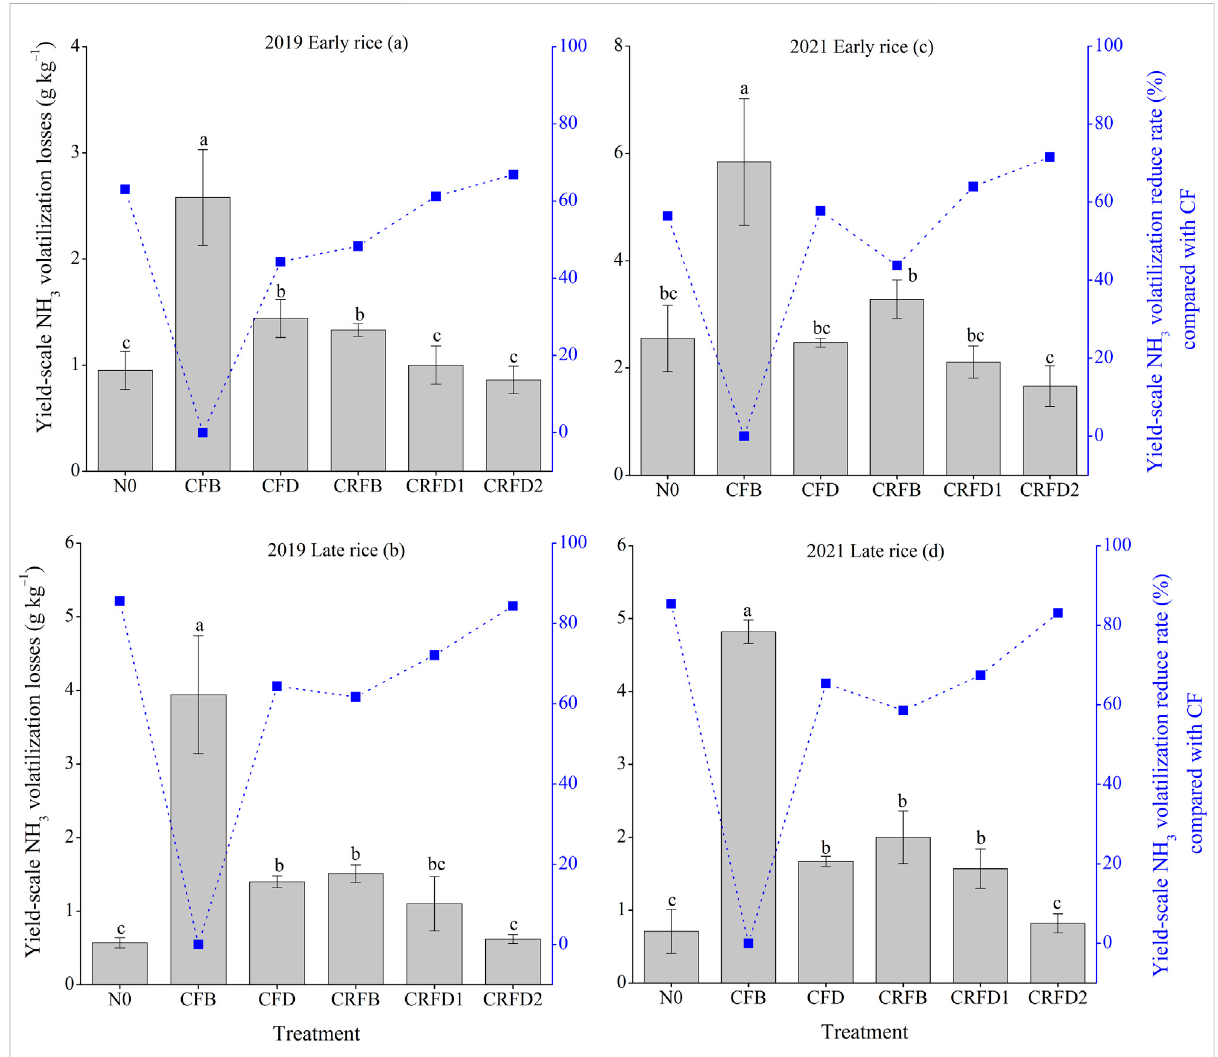
FIGURE 7 The yield-scale NH 3 volatilization losses for early (A,C) and late rice (B,D) under different treatments in 2019 (A,B) and 2021 (C,D) . Values are presentedasthemean±standarddeviation( n =3).Differentlowercaselettersabovethecolumnindicatesigni fi cantdifferenceat p < 0.05. N0:noN fertilizer; CFB: compound fertilizer broadcasting; CFD: compound fertilizer side-deep placement; CRFB: controlled-release N fertilizer broadcasting; CRFD1: controlled-release N fertilizer side-deep placement; CRFD2: controlled-release N fertilizer side-deep placement, one- time